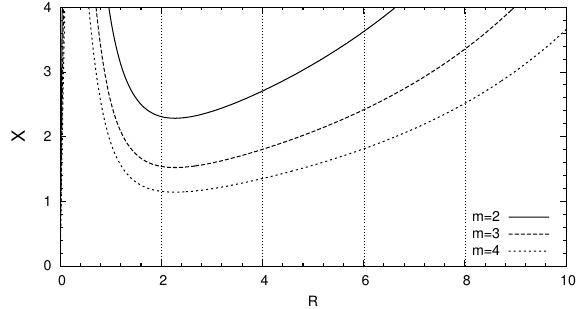
mechanism, which depends on two parameters, Q and X , X ≡ λ / λ crit , (9) θ λ = 2 π / k = 2 πR / m , λ crit = 4 π 2 GΣ 0 / κ 2 . As follows from θ θ the middle panel of Fig.7 in Toomre (1981), maximum am- plification for Q = 2 corresponds to X ≈ 1.8, and the effect vanishes for X (cid:38) 3 (see also Binney & Tremaine 2008, Fig- ure